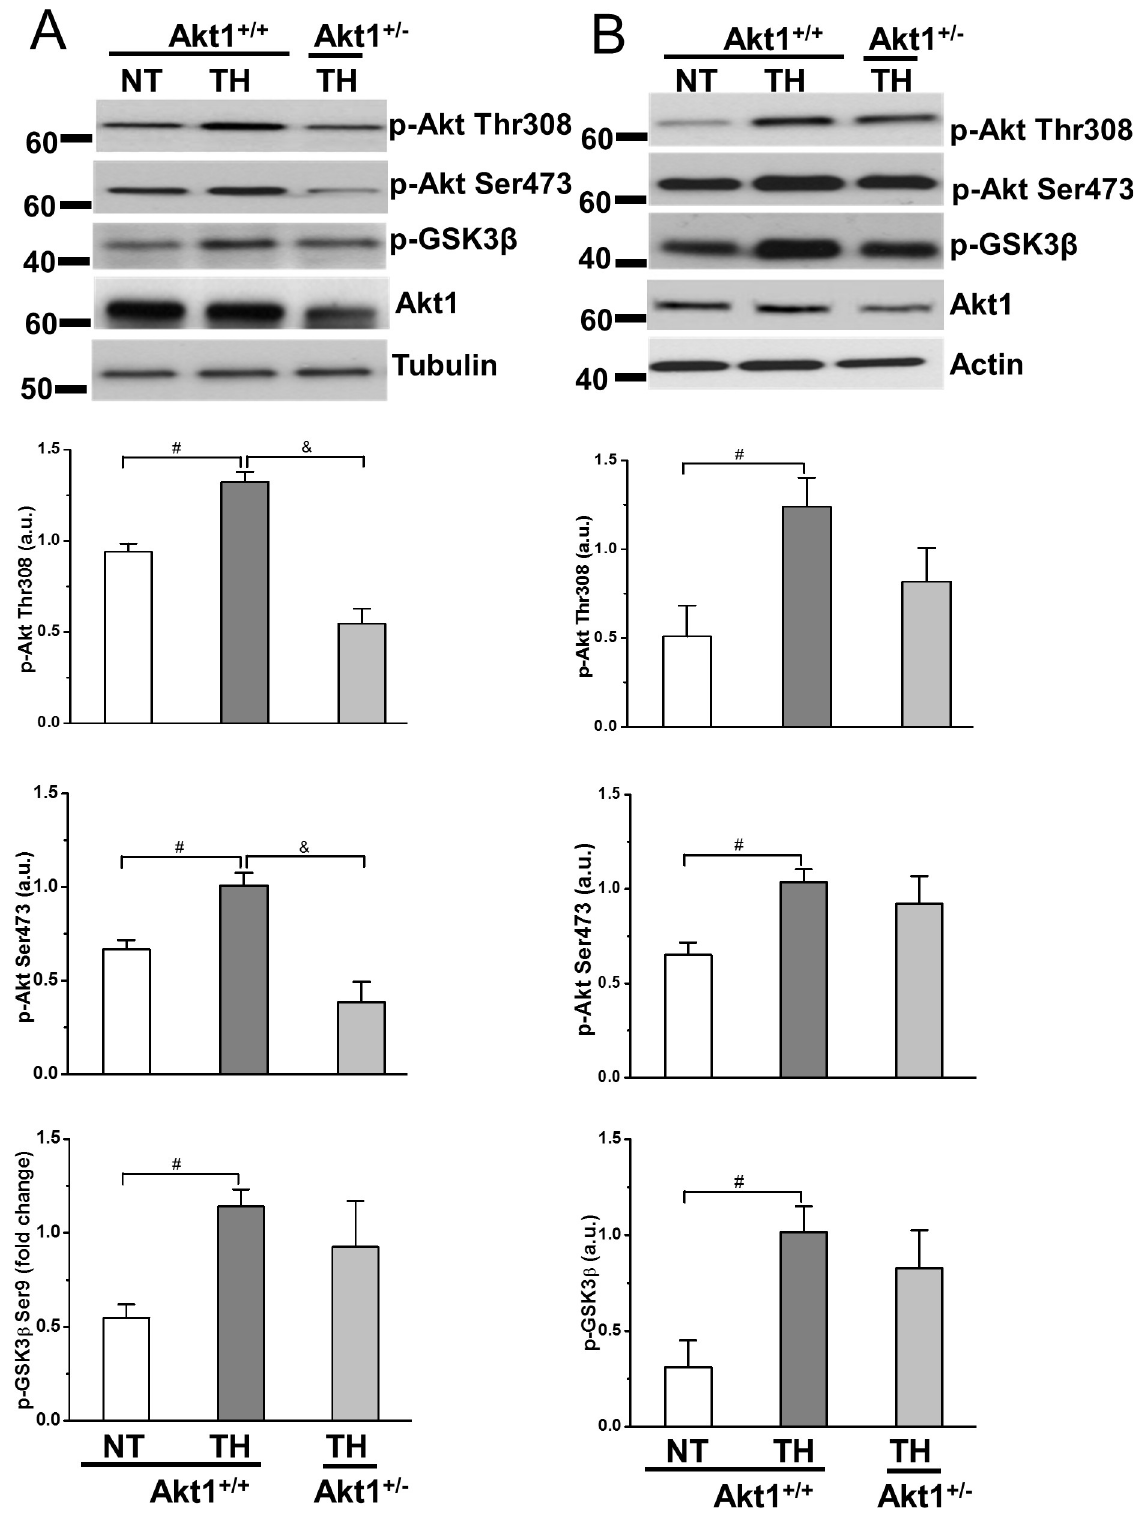
Fig 3. Phosphorylation of Akt and GSK3 β was analyzed by Western blot at R30 in heart and brain of Akt1 +/+ and Akt1 +/- mice with TH treatment. A : p-Akt Thr308, p-Akt Ser473 and p-GSK3 β Ser9 at R30 in heart. α -tubulin was used as loading controls for heart. B : p-Akt Thr308, p-Akt Ser473 and p-GSK3 β Ser9 at R30 in brain. β -actin was used as loading controls for brain. # p < 0.05 between NT and TH groups of Akt1 +/+ ; & p < 0.05 between TH-treated groups of Akt1 +/+ and Akt1 +/- mice. Data presented are means ± SEM of five mice. https://doi.org/10.1371/journal.pone.0220604.g003 PLOS ONE | https://doi.org/10.1371/journal.pone.0220604 August 9,